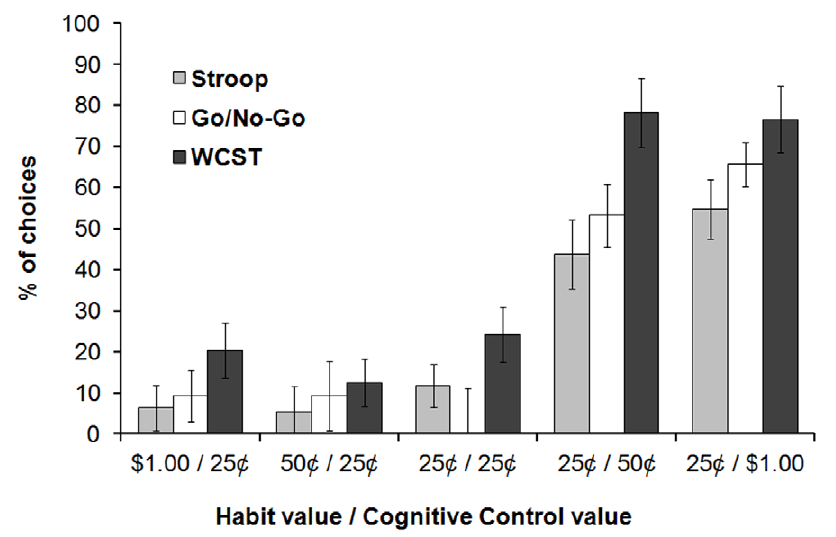
Figure 1. Behavioral Results. Percentage (%) of choices in which cognitive control was selected during the free-choice period as a function of expected monetary rewards. Error bars represent one (within-subject) standard error of the mean based on Loftus and Masson [69].